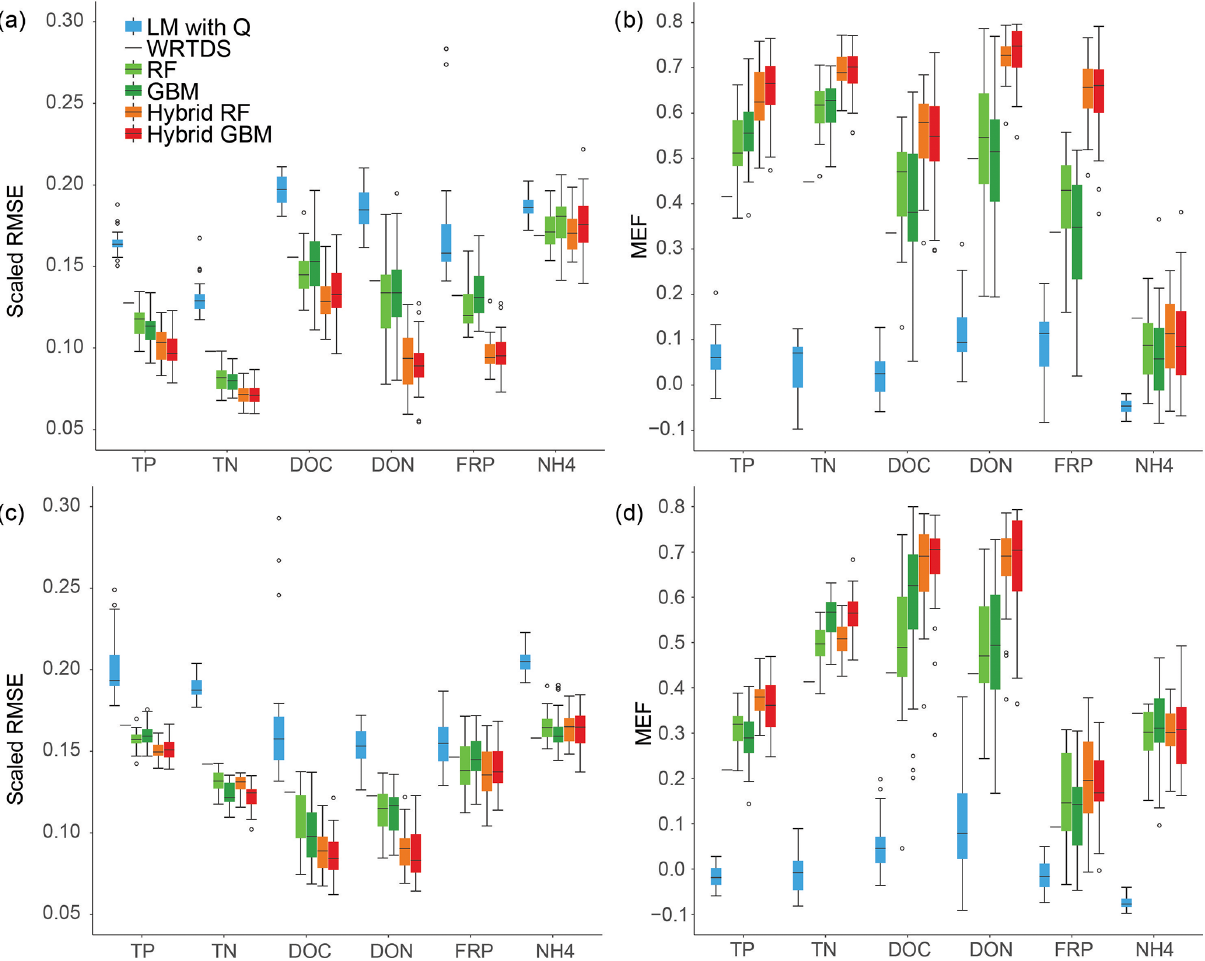
Figure 3. Model performance across six nutrients and the two sites: (a) RMSE and (b) MEF for Ellen Brook; (c) RMSE and (d) MEF results for Murray